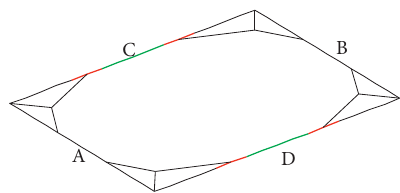
Figure 4: Boundary beam structure of the latticed shell.